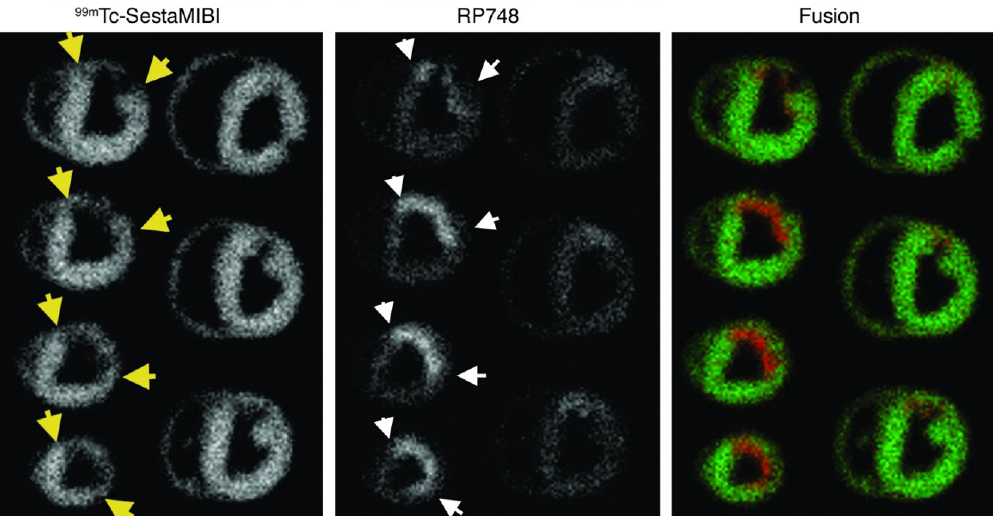
Figure 1. Integrin α v β 3-targeted imaging of myocardial angiogenesis. Example of ex vivo 99m Tc-sestamibi (reflecting perfusion, ( left )) and 111 In-RP748 (reflecting α v β 3 integrin expression and activation, ( center )) and fused color-coded ( right ) images of canine myocardium at three weeks post myocardial infarction induced by left anterior descending coronary artery occlusion. Yellow arrows point to the margins of the perfusion defect, and white arrows show the area of increased 111 In-RP748 uptake. On fused images perfusion tracer uptake is in green. RP748 accumulation (in red) is localized in the areas of perfusion defect. Published with permission of the American Society for Clinical Investigation, from “Noninvasive imaging of myocardial angiogenesis following experimental myocardial infarction”, Meoli, D.F., et al. J. Clin. Invest . 2004 , 113(12) , 1684–1691 [38]; permission conveyed through Copyright Clearance Center, Inc.